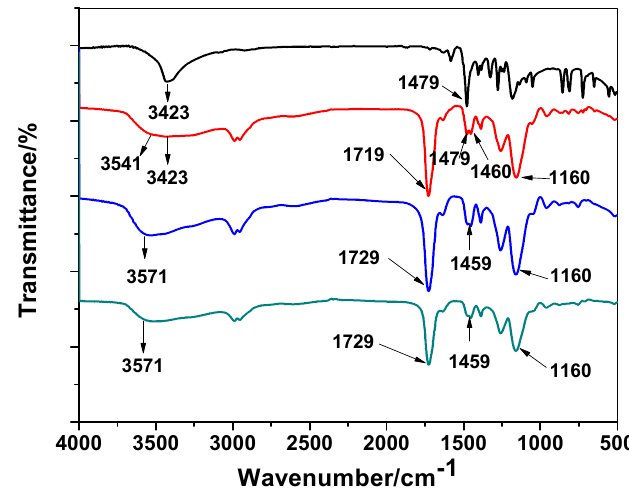
Figure 2. FT-IR spectra for 2,4-Dichlorophenol (DCP), DCP/molecularly imprinted polymers (MIP), MIP/washed and non-imprinted polymer (NIP) beads.